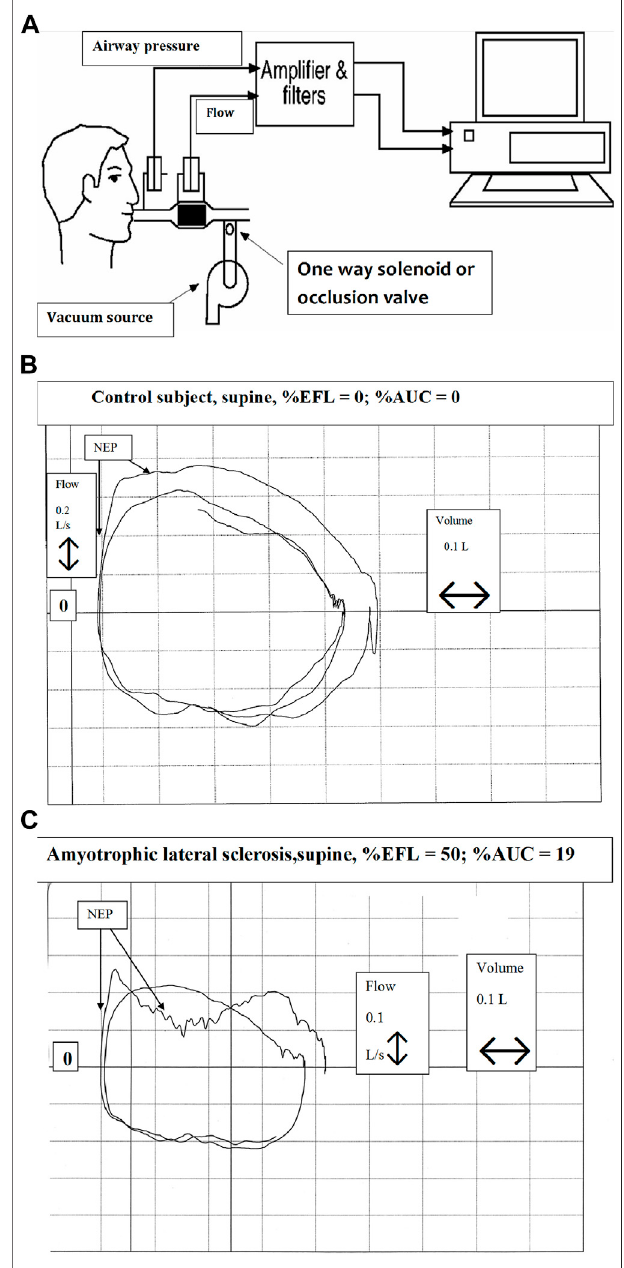
FIGURE 8 | Technique of negative expiratory pressure (NEP) (A) Equipment setup for assessment of expiratory fl ow limitation